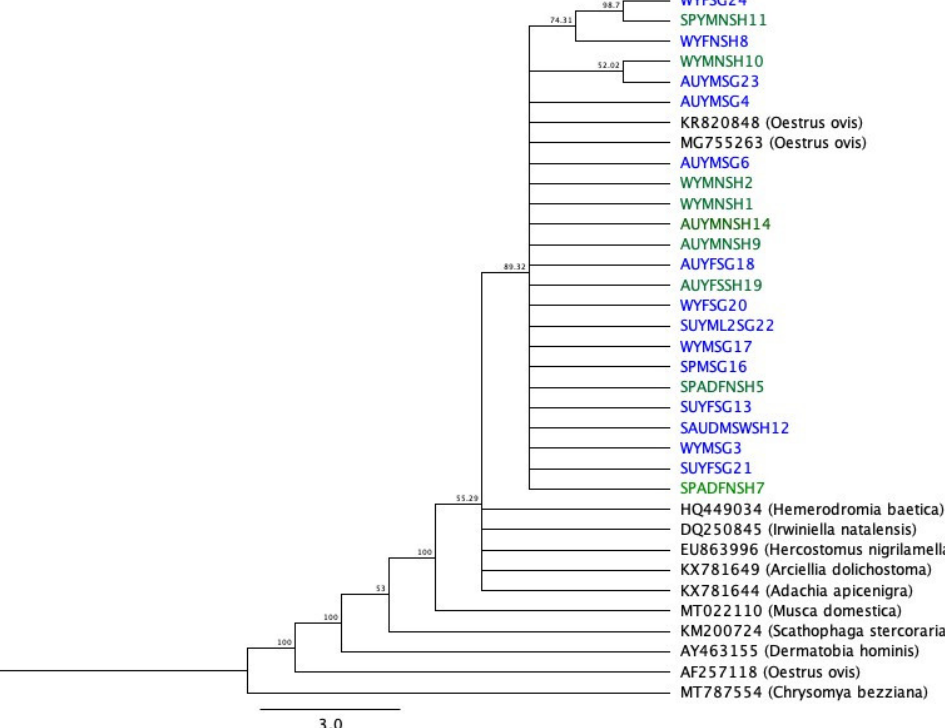
Figure 5. Genetic relationships of the mtCOI gene collected samples with other species retrieved from GenBank. The tree is generated using the neighbor-joining method, implemented in the Geneious software, with the Tamura_Nei model.